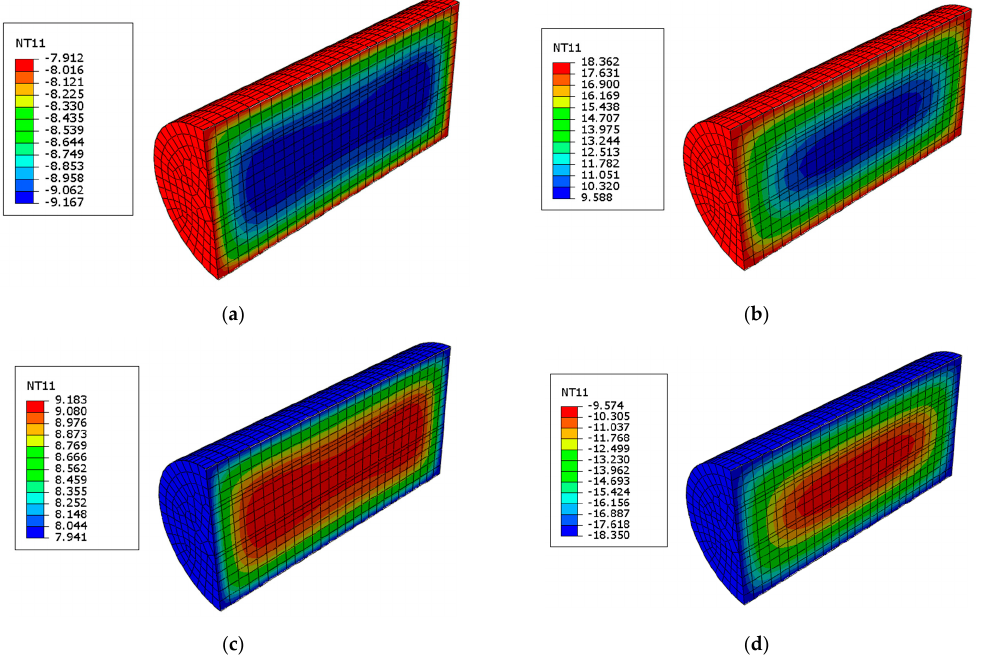
Figure 13. Freeze–thaw cycles simulation: ( a ) the node temperature of concrete at 2700 s; ( b ) the node temperature of concrete at 5400 s; ( c ) the node temperature of concrete at 8100 s; ( d ) the node temperature of concrete at 10,800 s.